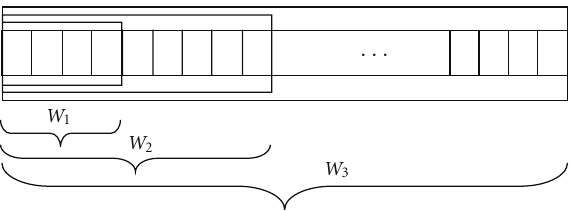
Figure 1: Expanding window structure with three